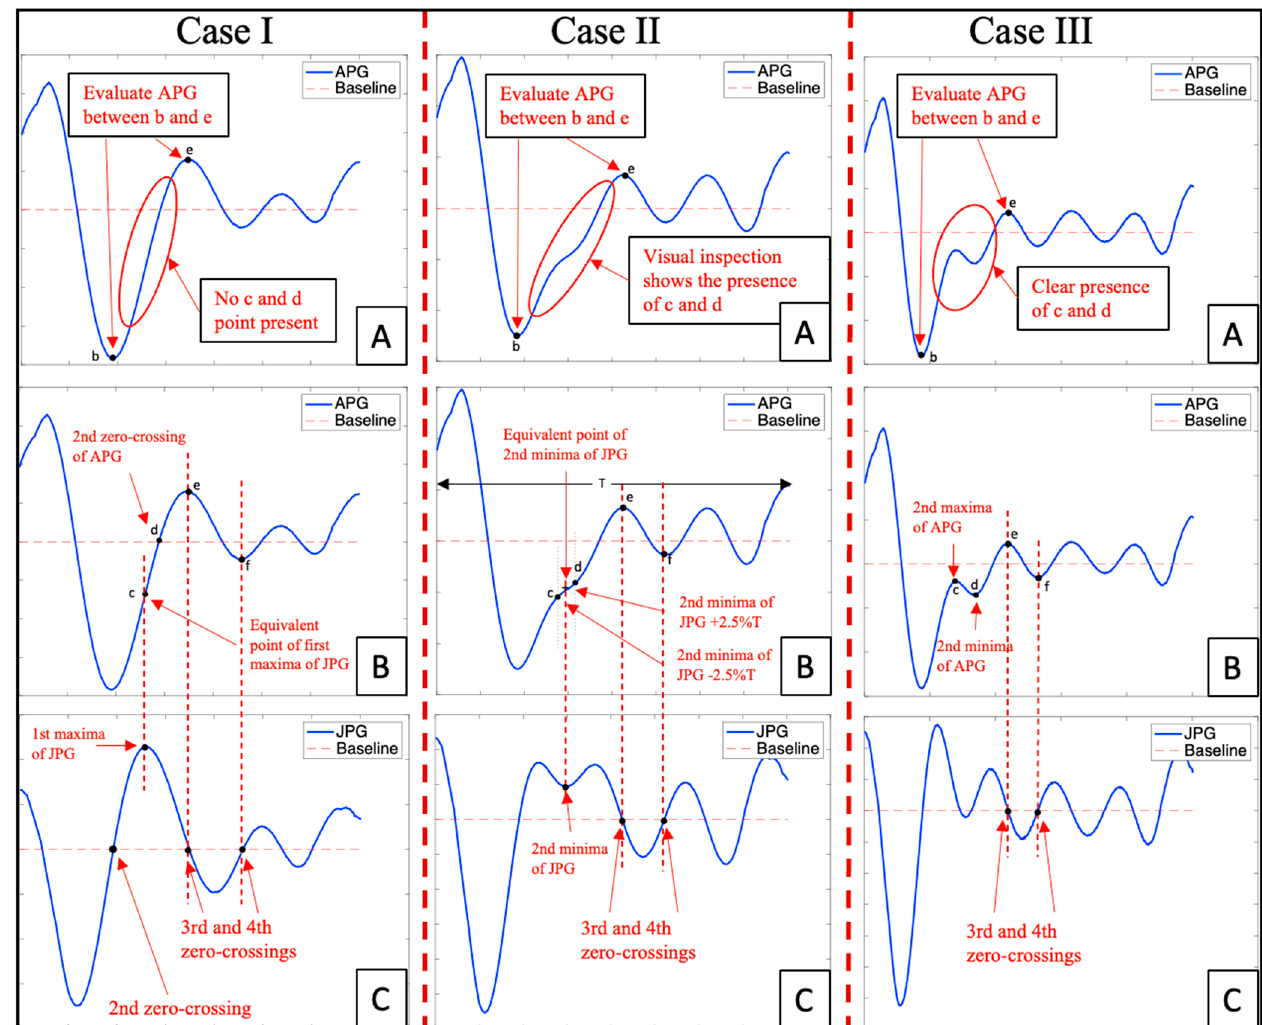
Figure 5. APG fiducial point extraction through Cases I–III, where ( A ) is the APG waveform examined by the algorithm between points b and e and it is classified into Case I–III based on this, ( B ) is the output waveform from the algorithm highlighting the fiducial point c and d, whereas ( C ) is the JPG waveform used to extract fiducial points for APG waveform.